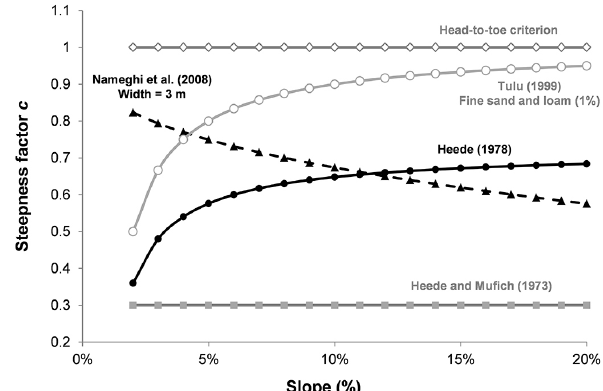
Fig. 11. Comparison of steepness factor c recommendations as a function of gully slope for check dam